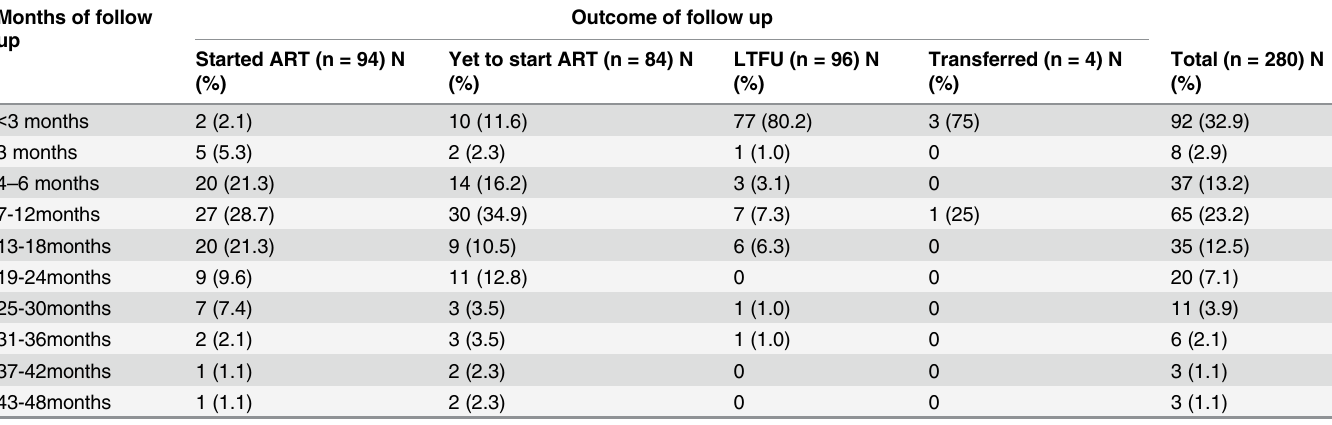
Table 1. Distribution of study participants according to outcome and duration of follow up.